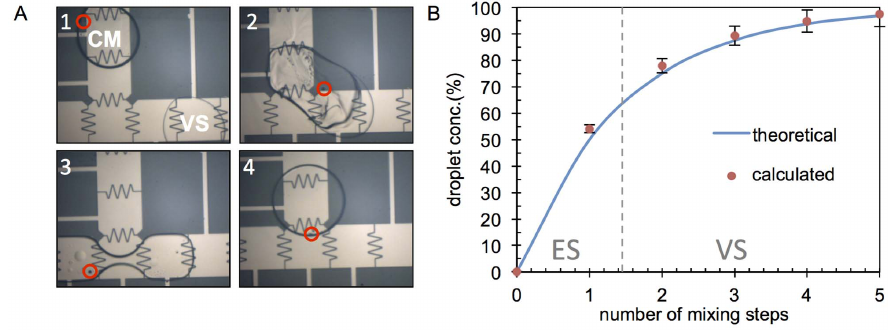
Figure 3. Droplet mixing protocol and resulting concentration profile. (A) 1: Embryo (red circle) contained in culture medium (CM) droplet. 2: Embryo droplet mixed with VS droplet. 3: Droplet split into two droplets (left contains embryo). 4: Droplet containing embryo is kept and other droplet is sent to waste. Process is repeated to increase VS concentration. (B) Mixing profile showing the generation of ES medium and VS medium. Droplet volumes were calculated by imaging droplet boundaries and modeling as cylinders. Concentrations were then calculated using these volumes before and after each mixing step.